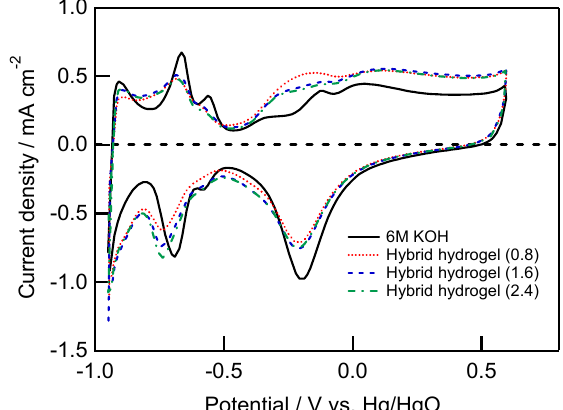
Figure 4. Cyclic voltammograms of a Pt electrode in three hybrid hydrogel electrolytes at 30 °C. Scan rate: 100 mV s − 1